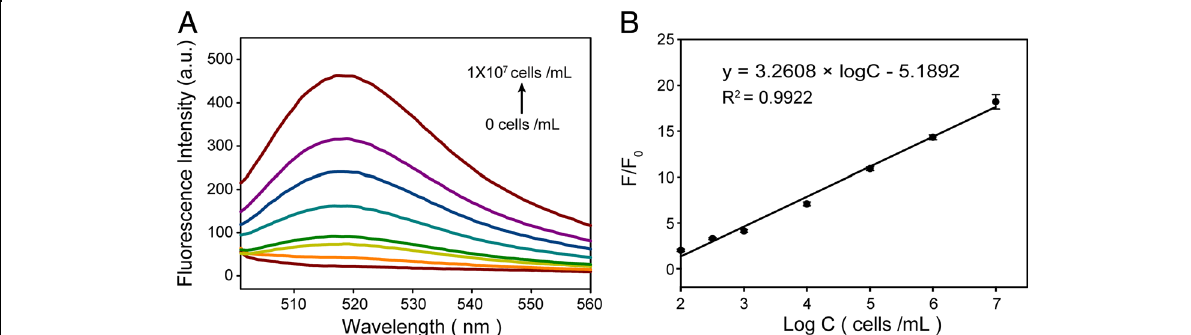
Fig. 6 Go-apt detection of CEM cells. a Fluorescence emission spectra of GO-apt fluorescent aptasensor in the presence of different concentrations of CCRF-CEM cells. b Linear relationship between the fluorescence intensity rate ( F / F 0 ) and the concentration of CCRF-CEM